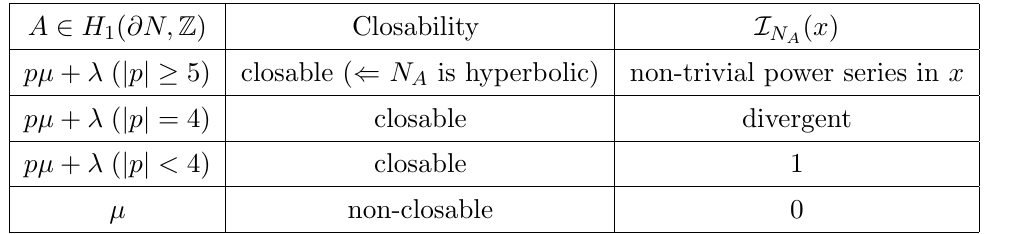
Table 2 . Closability of boundary cycles of N = S 3 n 4 1 . The (cid:22) is meridian and (cid:21) is